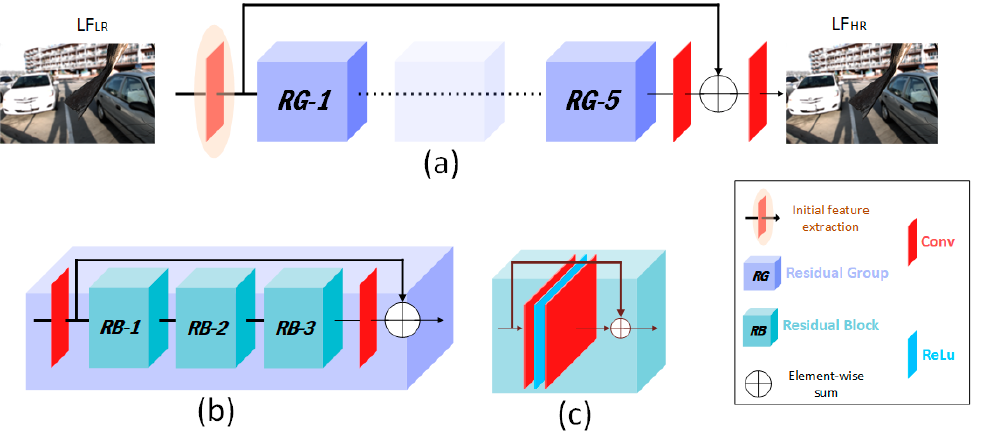
Figure 4. Nearest-view initialization method. ( a ) A 2D array of LF images where 7 × 7 views are to be reconstructed from 3 × 3 views bordered in light blue. ( b ) Input views (shown in bright colors) are used to assign their close neighboring views (shown in light colors) with the same value. After this initialization for all the views to be reconstructed, the raw LF images are created to be used as an input to the network.